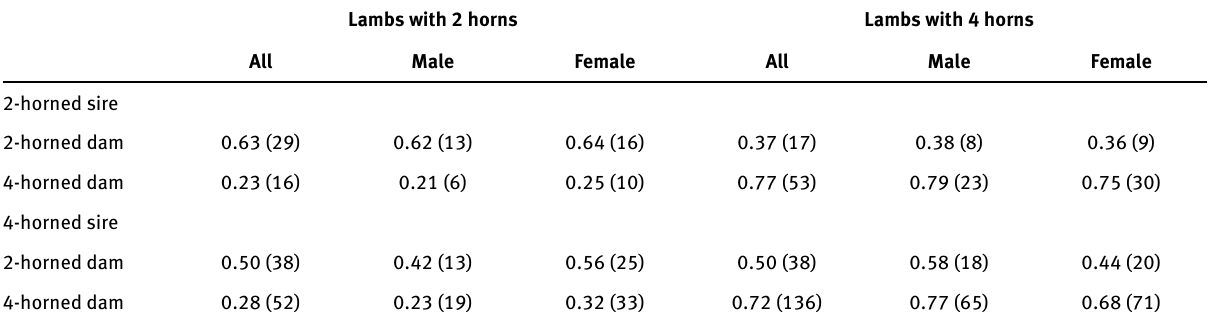
Table 1: Proportion of lambs born with either 2 or 4 horns, relative to the number of horns for each parent. Numbers shown in parenthesis are actual